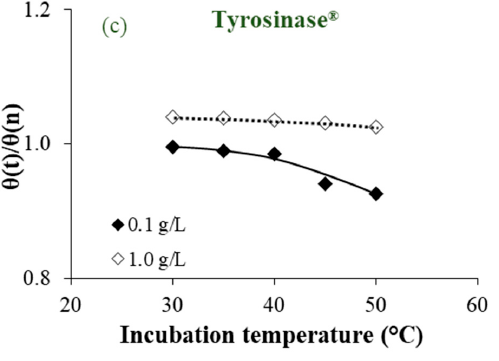
Figure 3. Dependence of the θ (t) for the treated CMX-Sb on incubation temperatures and concentrations of Rohalase ® ( a ), Corolase ® ( b ), and Tyrosinase ® ( c ).